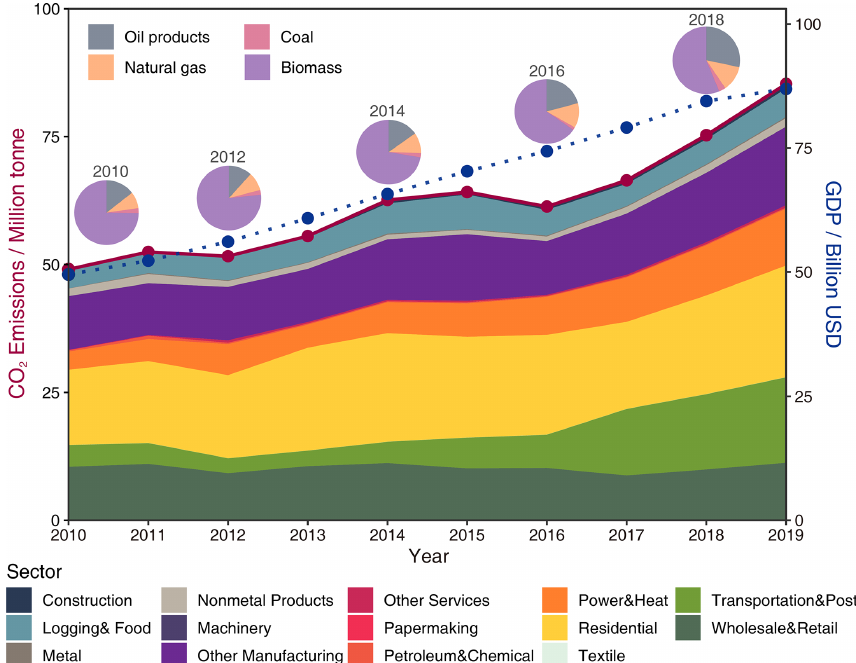
Figure 3. CO 2 emissions of Myanmar over 2010–2019. The red line shows the growth of CO 2 emissions, and the dotted blue line charts the growth of GDP. The pie charts show CO 2 emissions by energy source, the the area plot, and the area chart shows the CO 2 emissions by sector (17 sector aggregates merged from 47 sectors: see Table S4 in the Supplement for